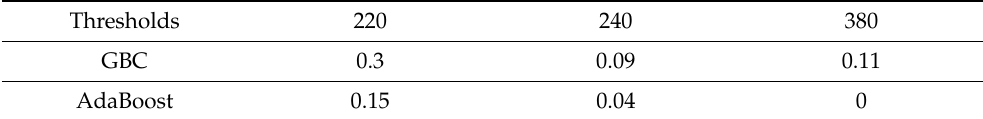
Table 5. Detecting all intoxicated subjects: FPR (false positive rate) of classifiers with a fixed TPR (true positive rate) of 1.0. Thresholds 220 240 380 GBC